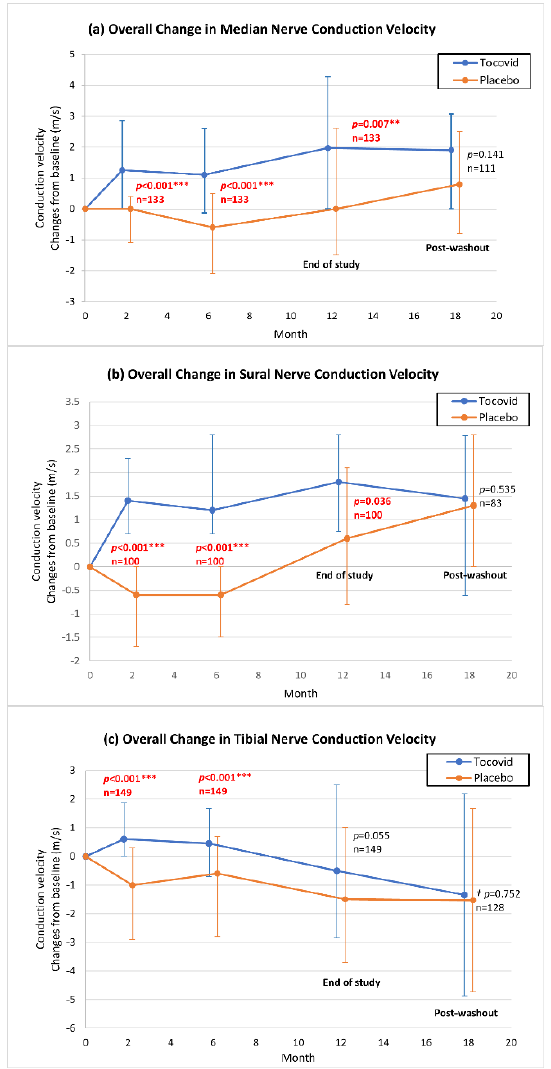
Figure 2. Graph of overall change in ( a ) median, ( b ) sural, and ( c ) tibial nerve conduction velocities. * p < 0.05, ** p < 0.01, *** p < 0.001. All data are presented as the median, with error bar representing the inter-quartile range. † Data are presented as the mean with error bars representing standard deviations.